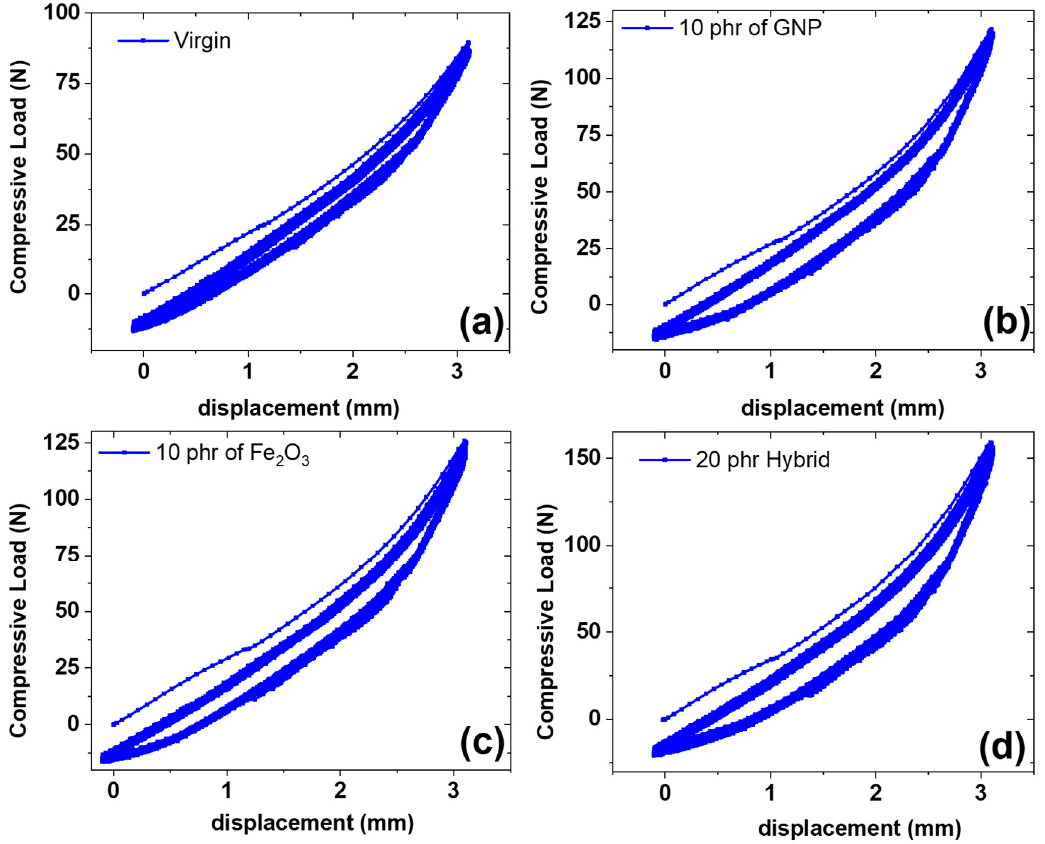
Figure 6. Compressive cyclic mechanical properties; ( a ) virgin composite, ( b ) GNP composite, ( c ) Fe 2 O 3 composite, ( d ) hybrid composite.